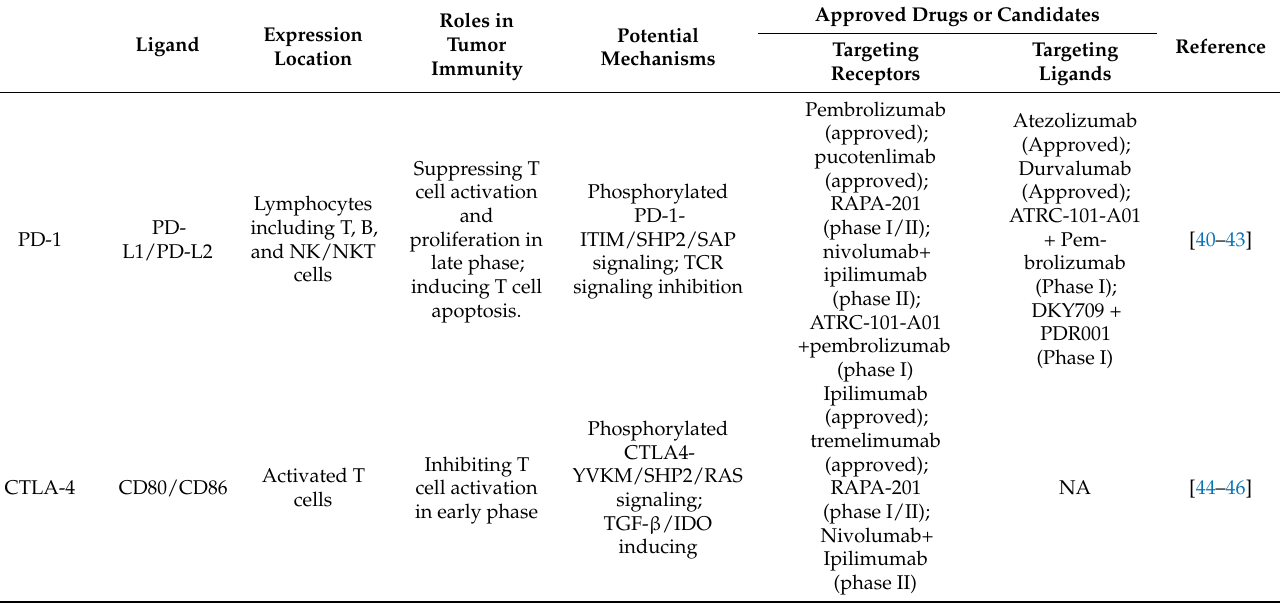
Table 2. Application of selected immune checkpoint blockade therapy in cancer